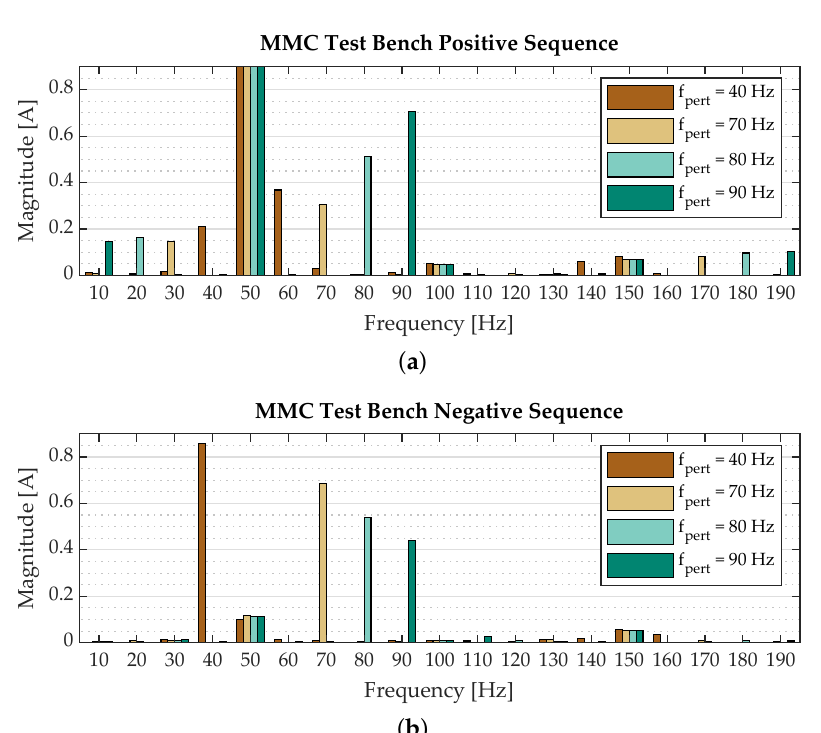
Figure 14. MMC TB current response spectrum with ( a ) positive-sequence and ( b ) negative- sequence